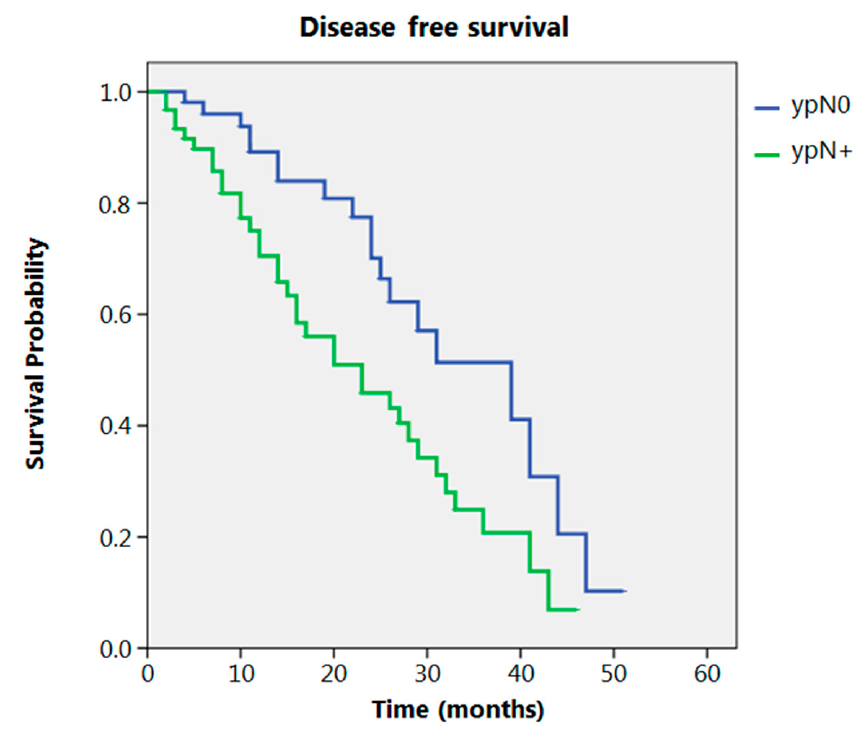
Figure 5. Disease free survival according to Figure 5 . Disease free survival according to ypN .